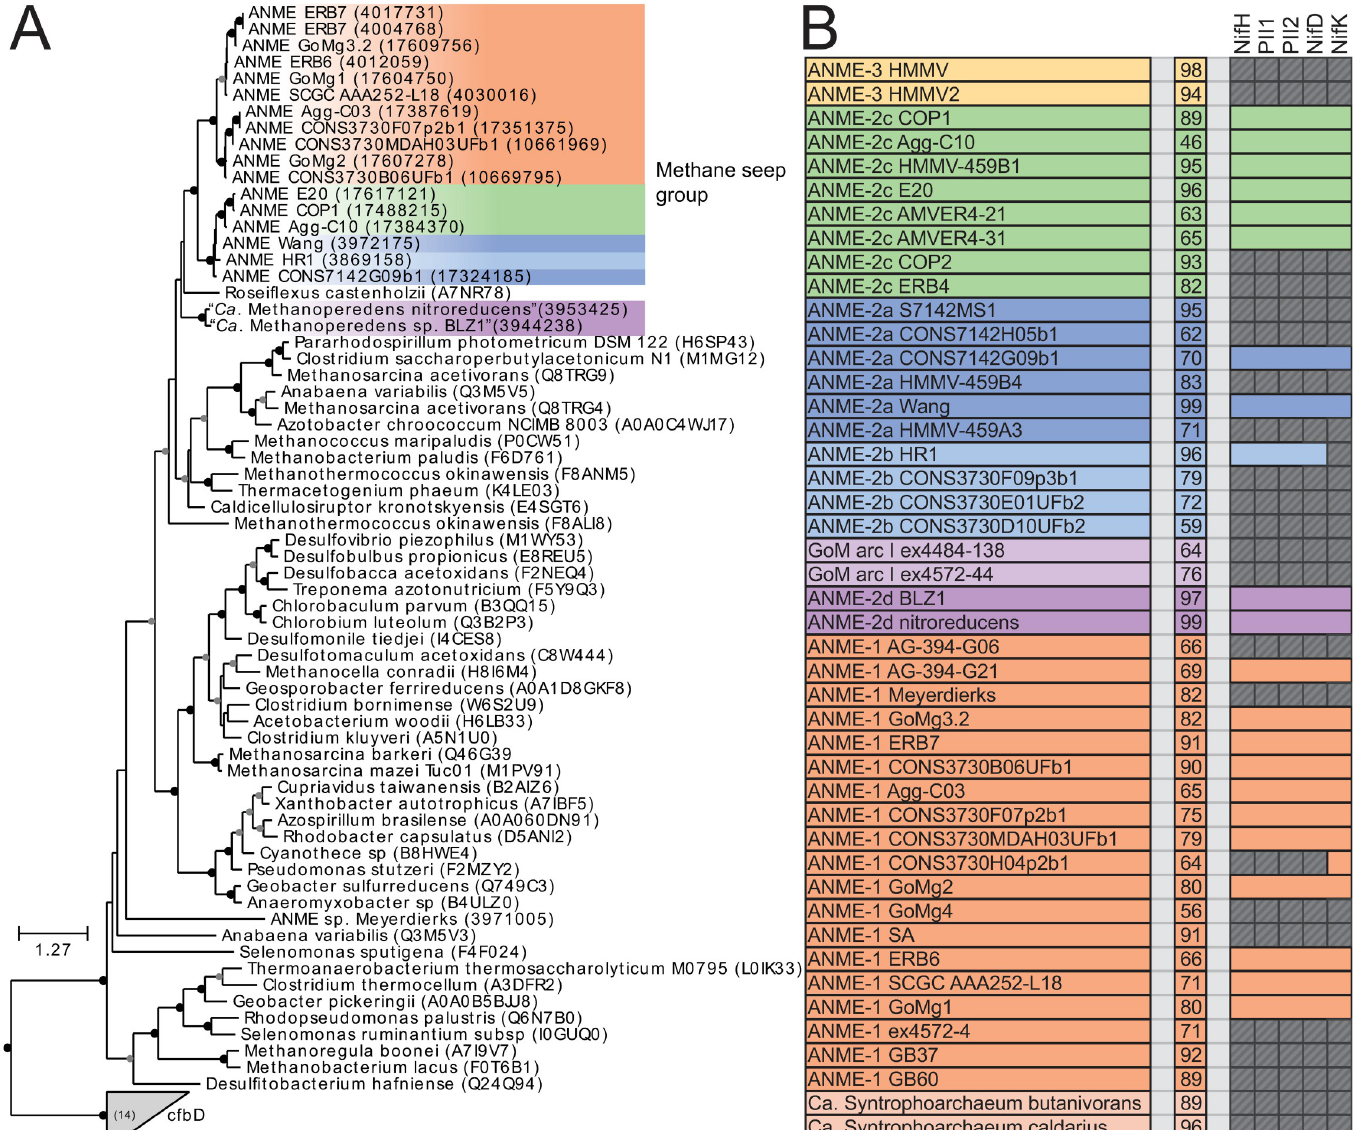
Fig 15. Methane seep group nitrogenase phylogeny and distribution. ( A ) Maximum likelihood phylogenetic tree of NifD amino acid sequences from the “methane seep” group of nitrogenase, with close relatives. Closed circles represent branch support values of 80% to 100%; gray circles between 70% and 80%. Tree scales represent substitutions per site. Tree construction parameters are found in the Materials and methods section. Alignments and tree files can be found in S1 Data . ( B ) Presence of seep group nitrogenase in genomes presented here. Colored boxes represent presence of various nitrogenase related genes in ANME genomes. Missing genes are represented by gray boxes with diagonal line fill. Numbers in the second column represent genome completeness. When genes are together in a gene cluster, their boxes are displayed fused together. Gene accession numbers can be found in S2 Data . ANME, anaerobic methanotrophic.